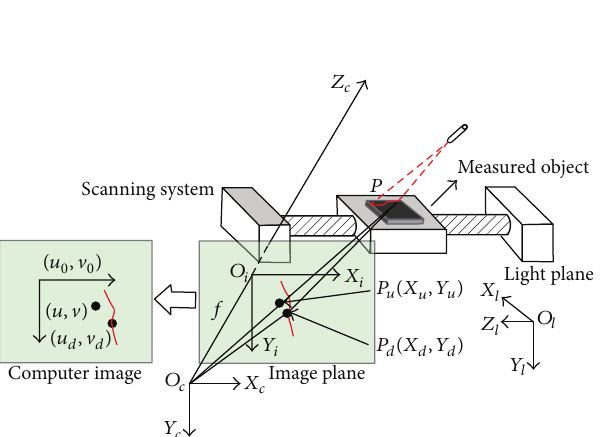
Figure 1: Structure of the system of vision measurement.